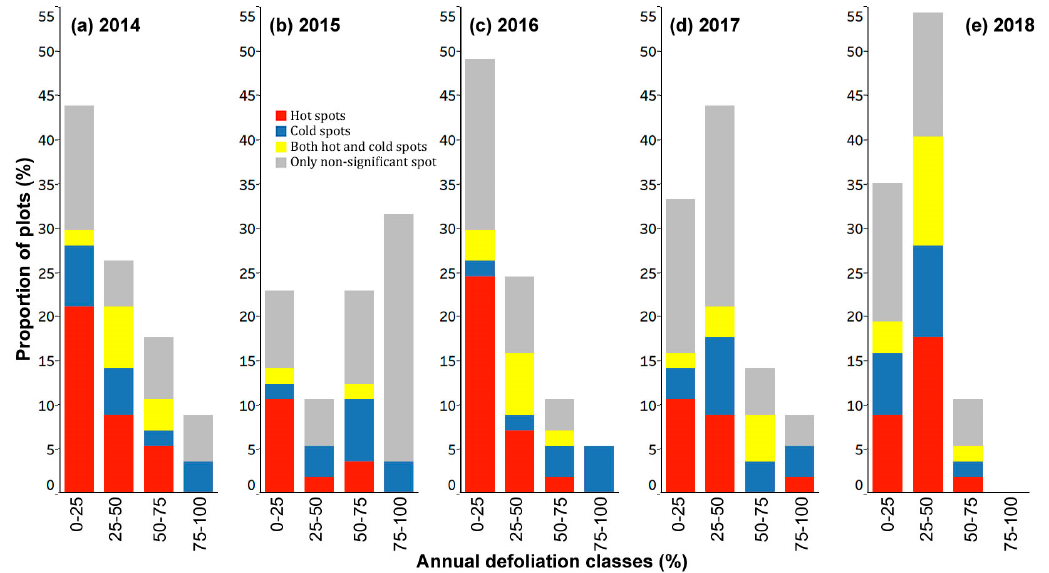
Figure 3. Proportion of plots with hot spot trees, cold spot trees, both hot and cold spot trees, and only non-significant trees (based on results of Getis-Ord Gi* analyses ( α = 0.05)) by 25% annual defoliation classes from 2014 to 2018 ( a – e ).